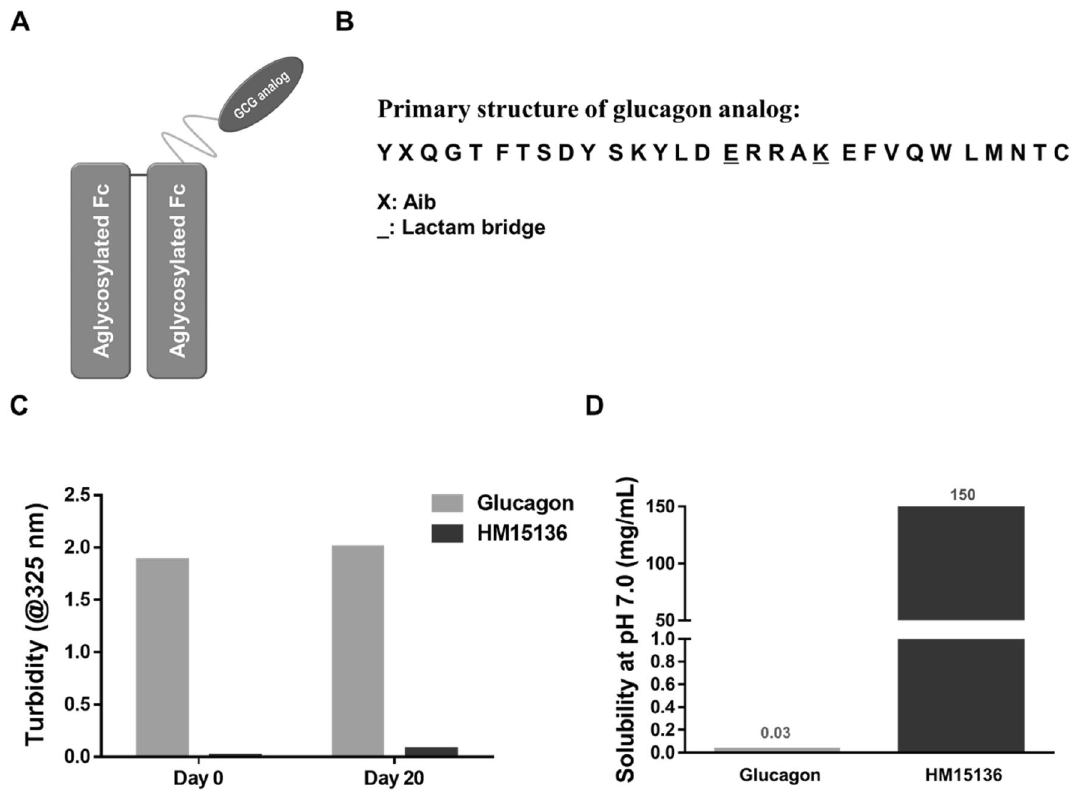
Figure 1. Structure of HM15136, conjugate of glucagon analog and human immunoglobulin G4 Fc. ( A ) Structure of HM15136. ( B ) Primary sequence of glucagon analog. ( C ) Physical stability of HM15136